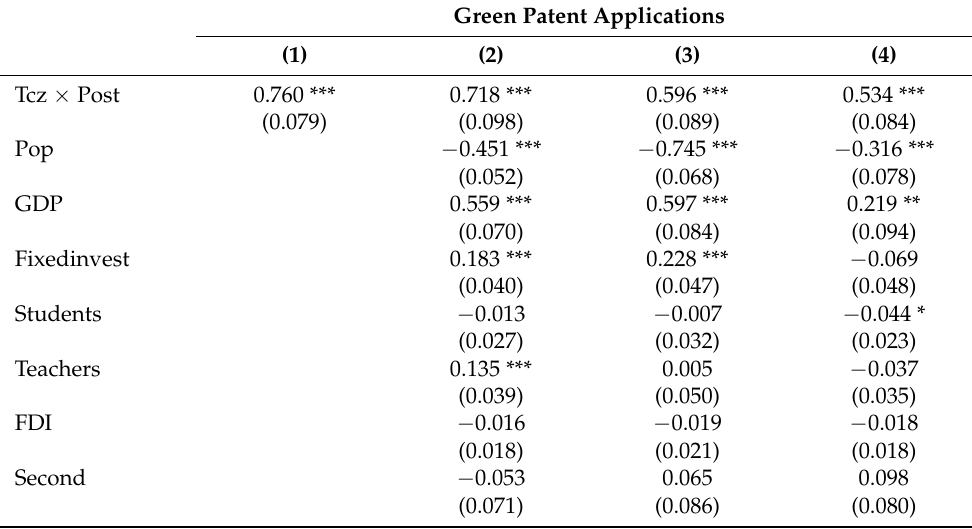
Table 2. Baseline